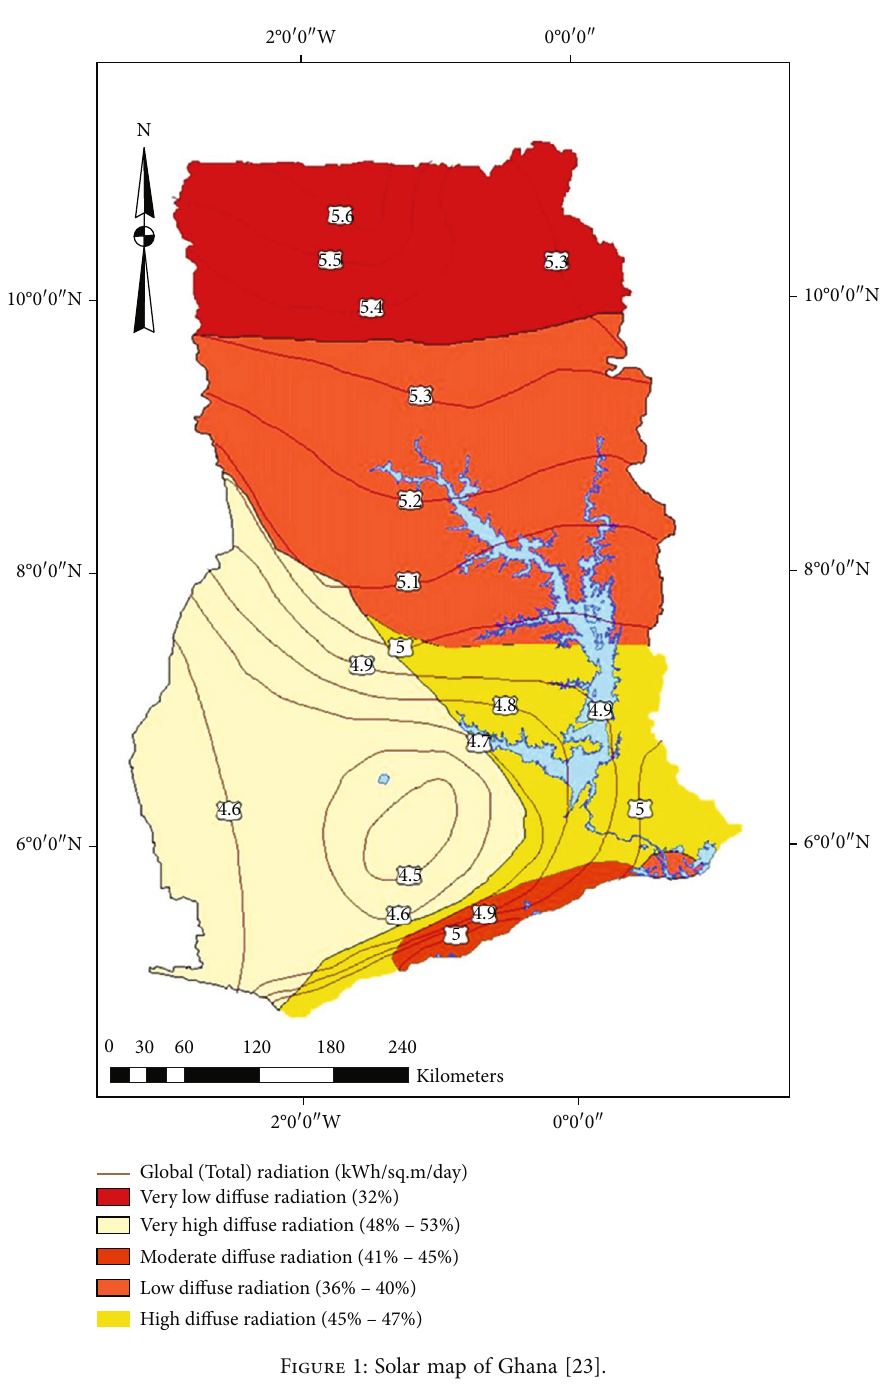
Figure 1: Solar map of Ghana